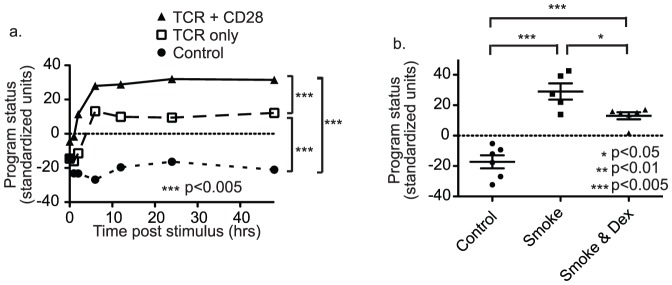
Measuring gene expression system modulation at the program level.Panel (5a) shows a time course of program status measures after stimulation of the T cell receptor (TCR) alone or in combination with the co-stimulatory molecule (CD28). Results are compared to time-matched non-stimulated controls. Plot shows that co-stimulation with CD28 increases gene expression program progression resulting in a higher plateau in terms of program status. There was a significant difference in plateau program status measures (6–48 hour post-stimulation). Significance was calculated using repeated measures one-way ANOVA with Bonferoni correction for multiple testing. Panel (5b) shows a comparison of gene expression program status in tracheal explant cultures 24 hours after stimulation with smoke or smoke with dexamethasone pretreatment [18]. Results were compared to time matched untreated explants. Plot shows that pretreatment with dexamethasone decreases gene expression program progression. There was a significant difference between program status measures in smoke and smoke plus dexamethasone conditions. Significance was calculated using one-way ANOVA with Bonferoni correction for multiple testing.